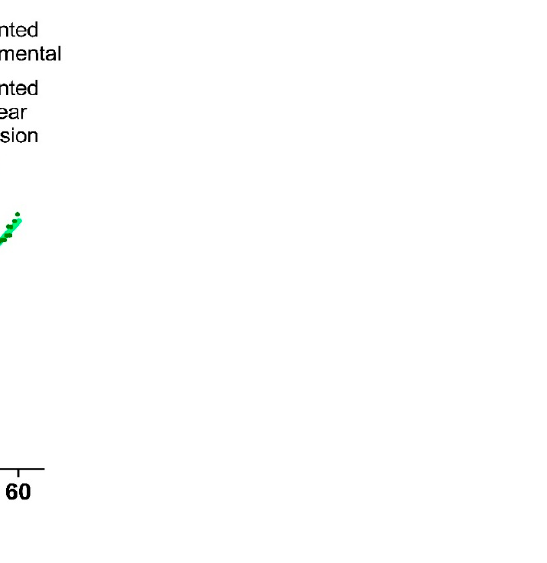
Figure 13. Fluorescent images of DAPI-stained mesenchymal stem cells (MSC) on the surface of: ( A – C )—cryogelated matrix PLA-MA/NCC-MA + 20% PEGDA; ( D – F ) 3D-printed matrix PLA-